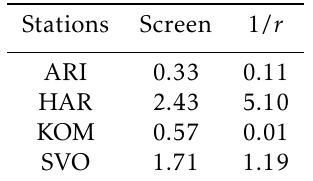
Table 1: Standard deviation distances ( S ) for predic- tions from the screen approximation and 1/ r